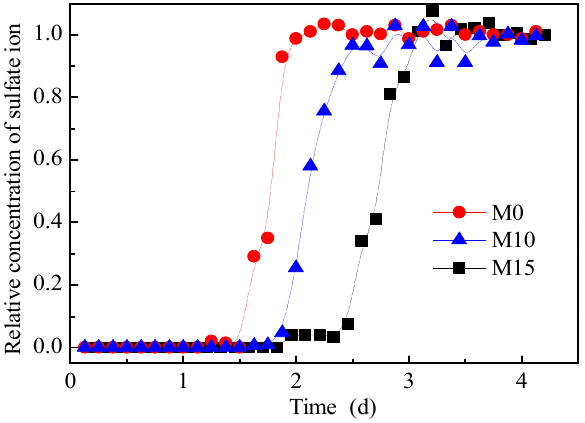
Figure 6. Results of the ion exchange equilibrium experiment.